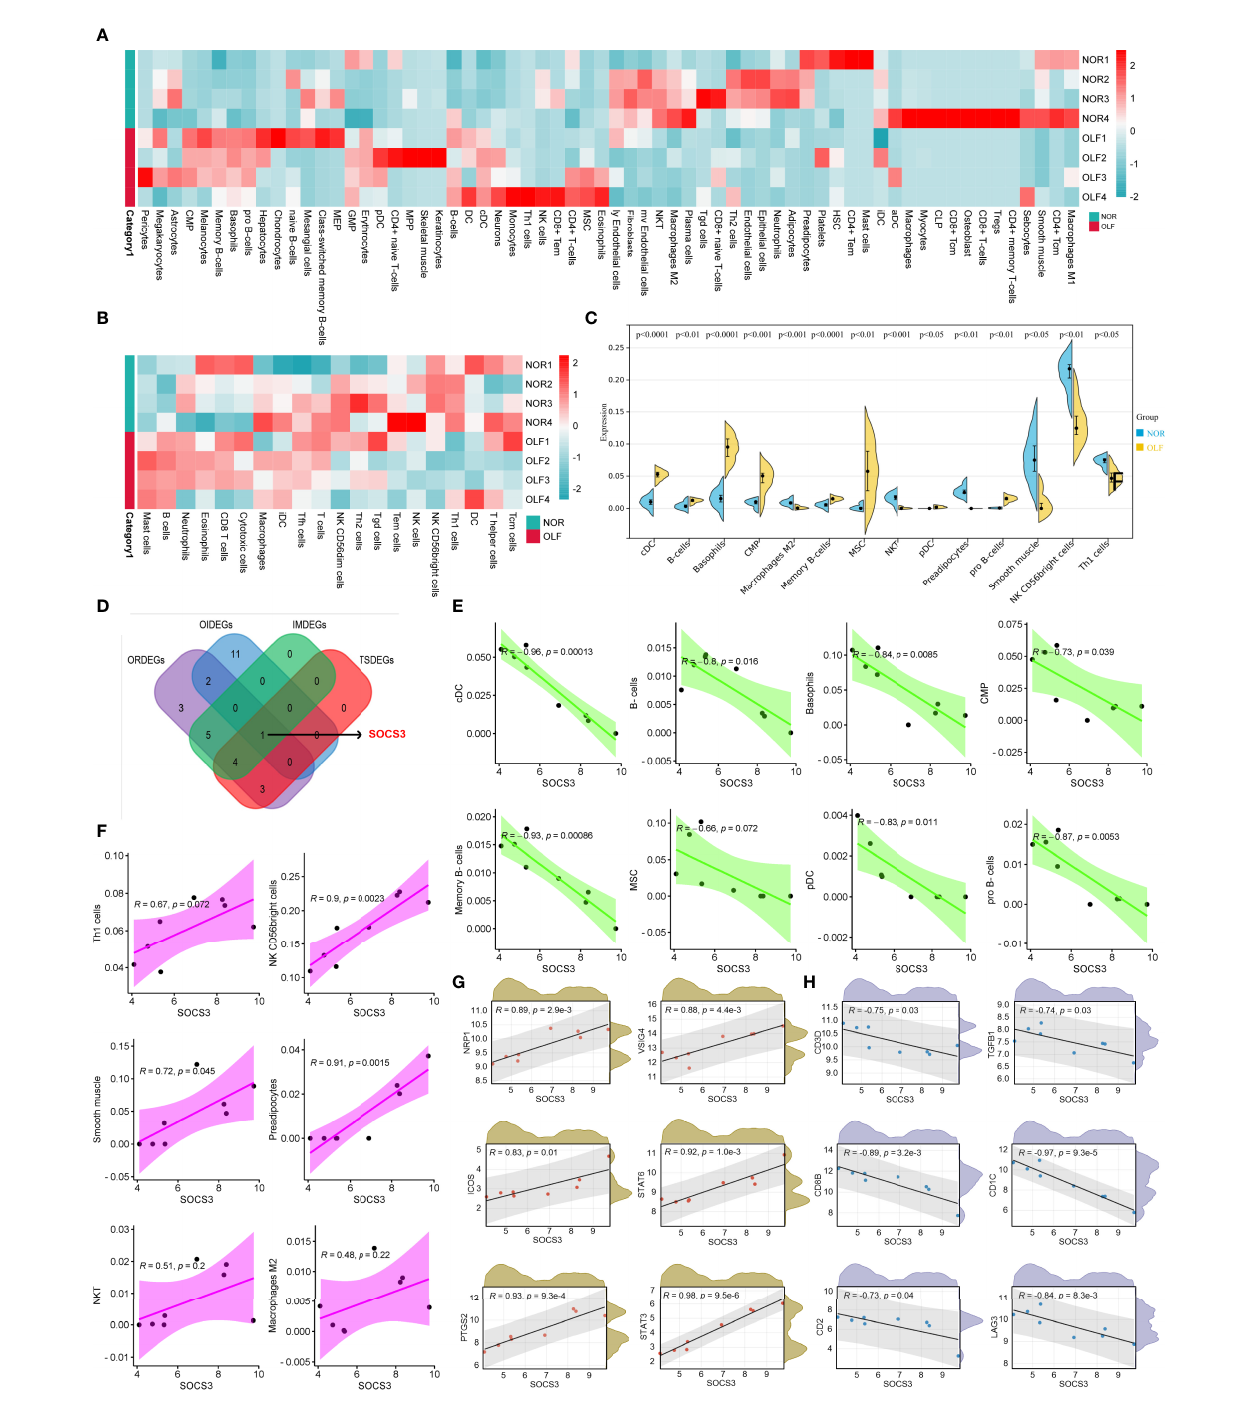
FIGURE 7 | Correlation analysis of SOCS3 and OIICs as well as immune marker sets. (A) Heatmap of 64 in fi ltrating immune cells between normal and OLF tissues. (B) Heatmap of 23 in fi ltrating immune cells between normal and OLF tissues. (C) The expression level of 14 differential immune cells between normal and OLF samples. (D) Venn diagram showed the intersection among ORDEGs, OIDEGs, IMDEGs, and TSDEGs to identify SOCS3 as the core gene. (E) SOCS3 expression showed a negative correlation with the levels of cDC cells, B-cells, basophils, CMP, memory B-cells, MSC, pDC, and pro B-cells. (F) SOCS3 showed a positive correlation with the levels of Th1 cells, NK CD56 bright cells, smooth muscle cells, preadipocytes, NKT cells, and macrophages M2. (G) The expression of SOCS3 was positively correlated with the immune markers NRP1, VSIG4, PTGS2, ICOS, STAT3 and STAT6. (H) The expression of SOCS3 was negatively correlated with the immune markers CD1C, CD3D, CD2, CD8B, TGFB1 and